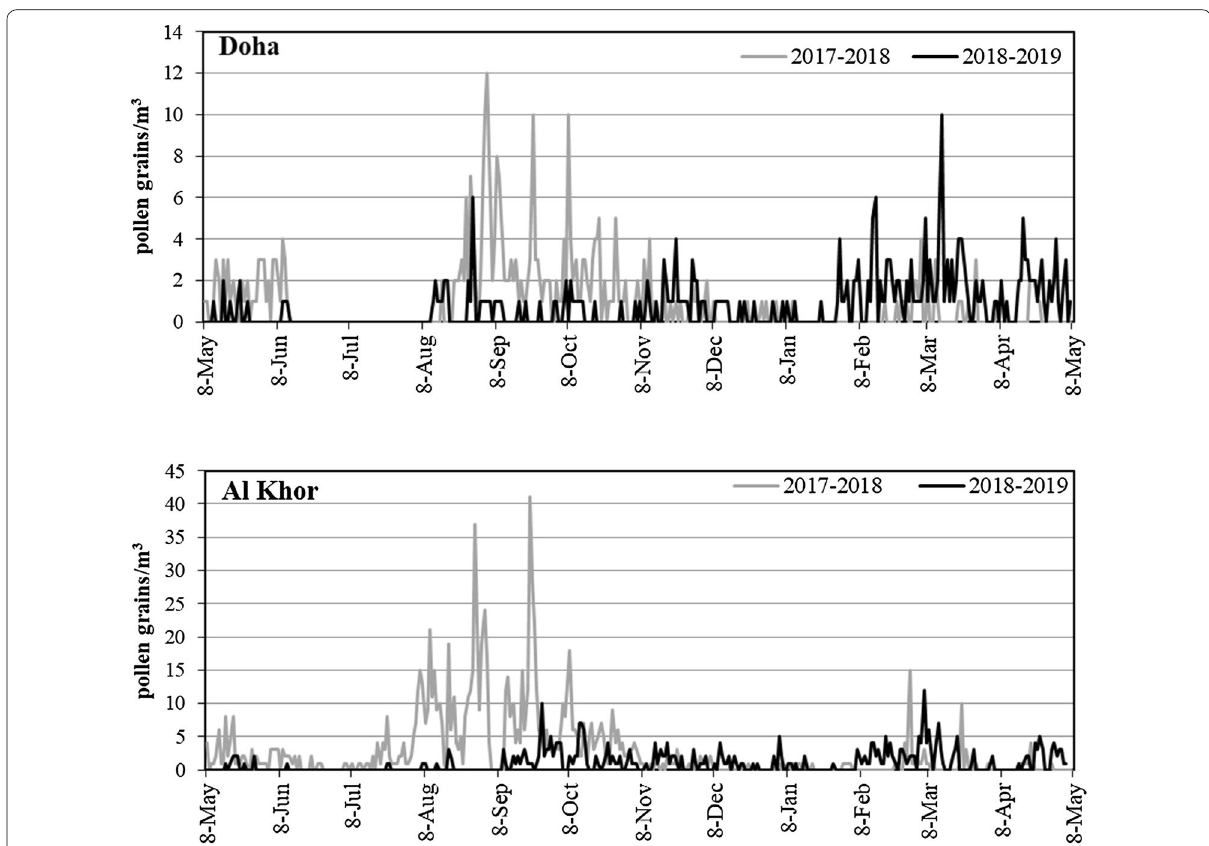
Fig. 1 Seasonal variation of the daily mean total count (pollen grain/m 3 ) of pollen in the sampling sites. Two sampling stations in two different cities recorded pollens over 2 years in the atmosphere of Qatar. The seasonal peak was observed in the periods between August to October, and February to March. The maximum concentration of pollen was 40 pollen grains/m